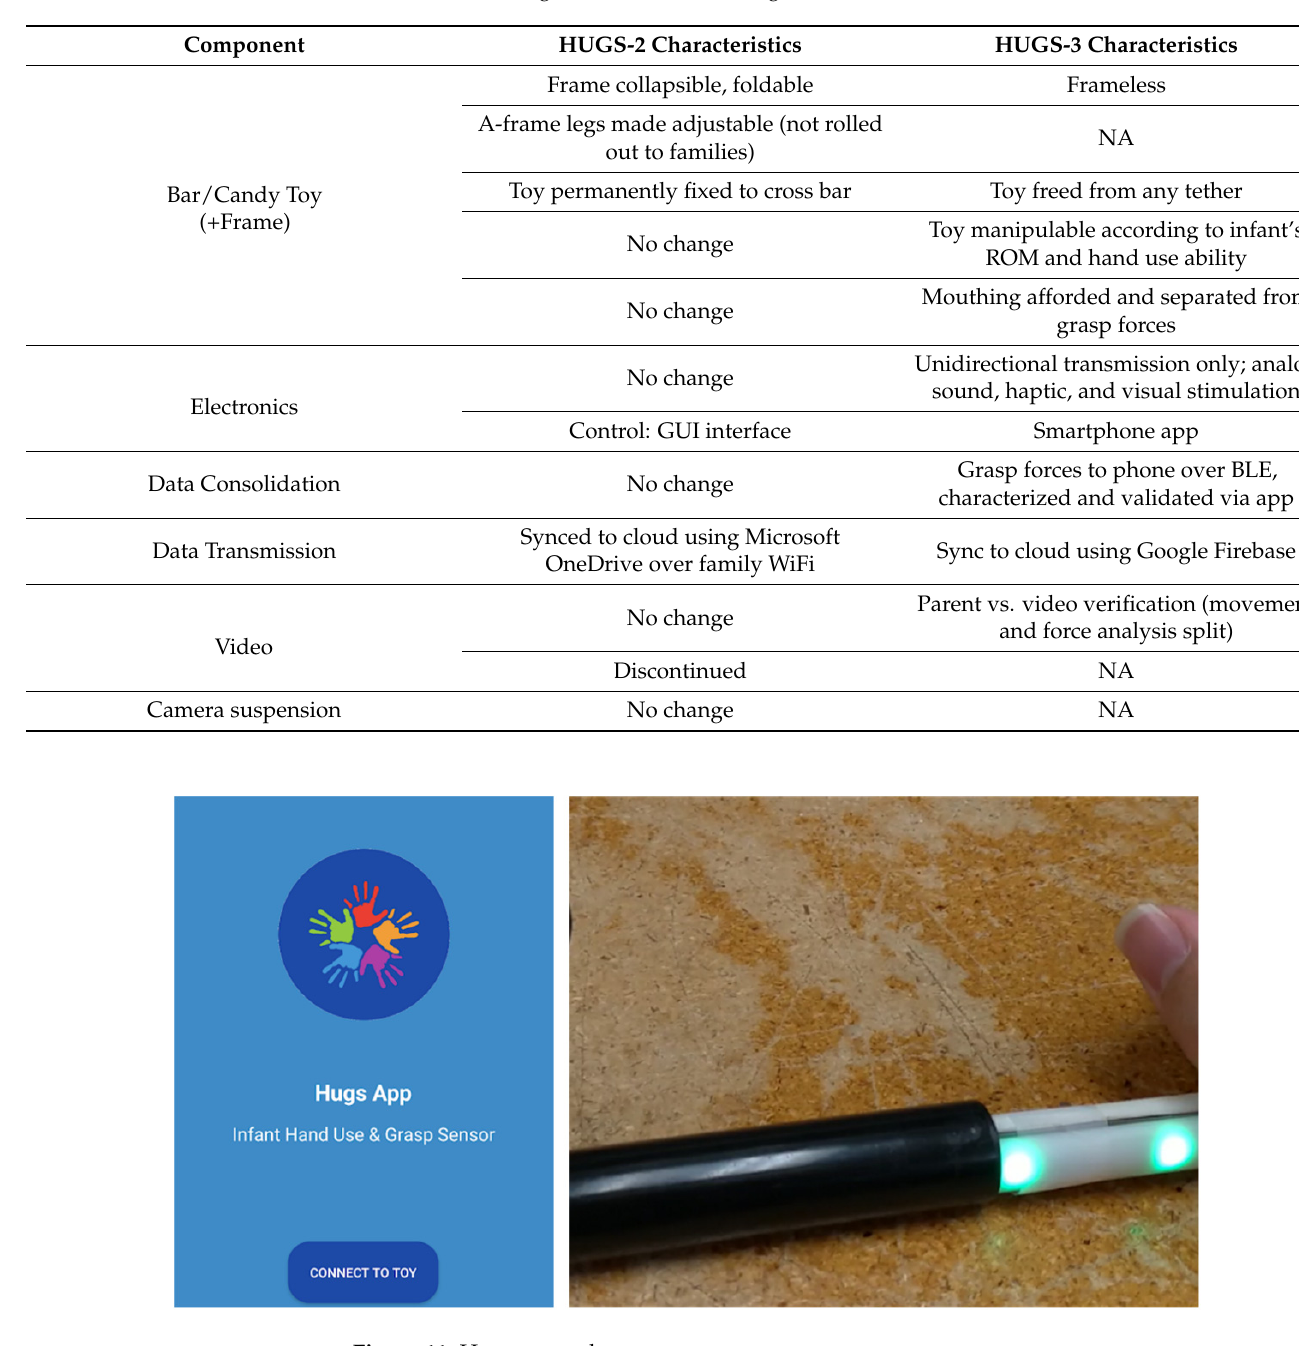
Figure 11. Hugs smartphone app